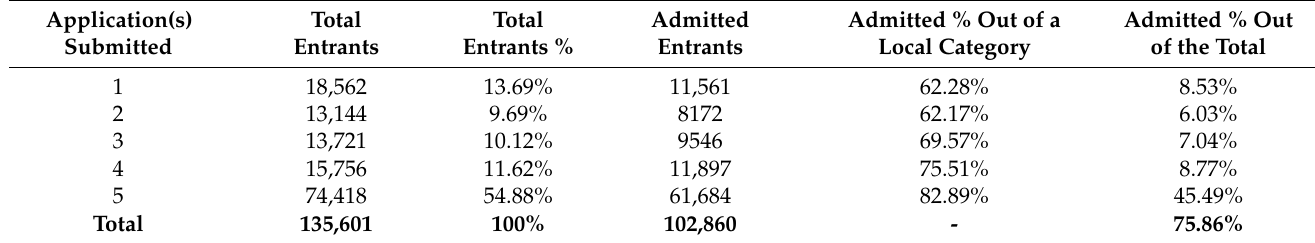
Table 4. Statistics on entrants who applied for state-funded